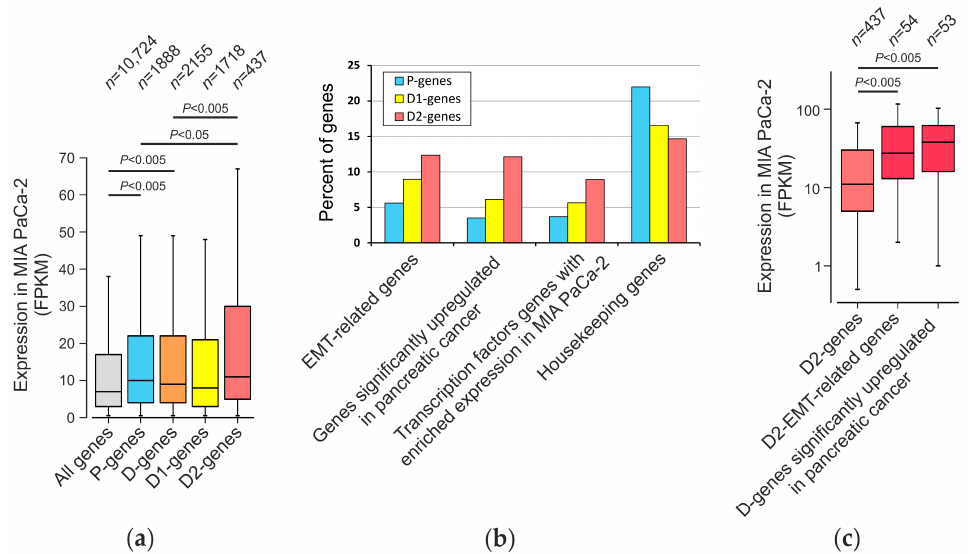
Figure 5. Expression of genes associated with mapped regions in MIA PaCa2 cells. Expression is presented in FPKM (fragments per kilobase of a transcript per million mapped reads). “Box and whiskers” plot shows distribution of the genes by expression levels (Mann–Whitney test, min–max range, 1.5 IQR, cut-off level 0.5 FPKM). ( a ) P-, D1- and D2 genes (see the text) were determined by GREAT (Genomic Regions Enrichment of Annotations Tool) [43], and their expression in MIA PaCa2 cells was estimated using Expression Atlas [44]. ( b ) The percentage of different functional types of genes in P- and D groups. ( c ) The most active D2 genes are EMT-related genes as well as genes with elevated expression in pancreatic cancer [45] .